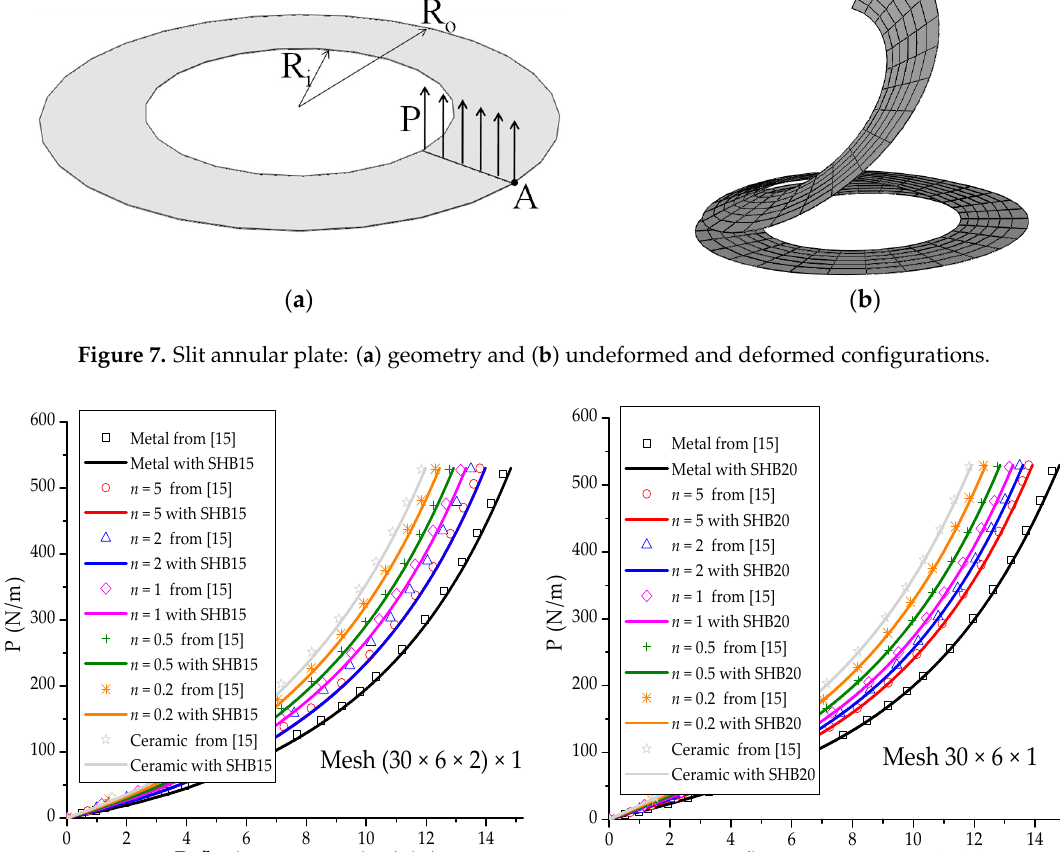
( b ) Figure 6. Load–deflection curves for the cantilever beam. ( a ) Prismatic SHB15 element; ( b ) hexahedral SHB20 element. 3.2. Slit Annular Plate In this section, the well-known slit annular plate problem is considered (see, e.g., [29–31]). The annular plate is clamped at one end and loaded by a line shear force P, as illustrated in Figure 7a. The inner and outer radius of the annular plate are